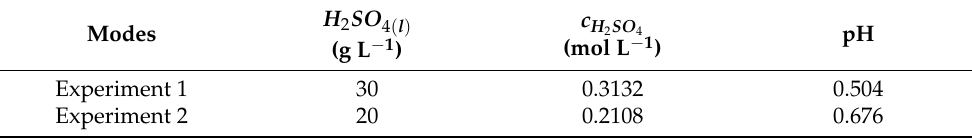
Table 3. Experiment